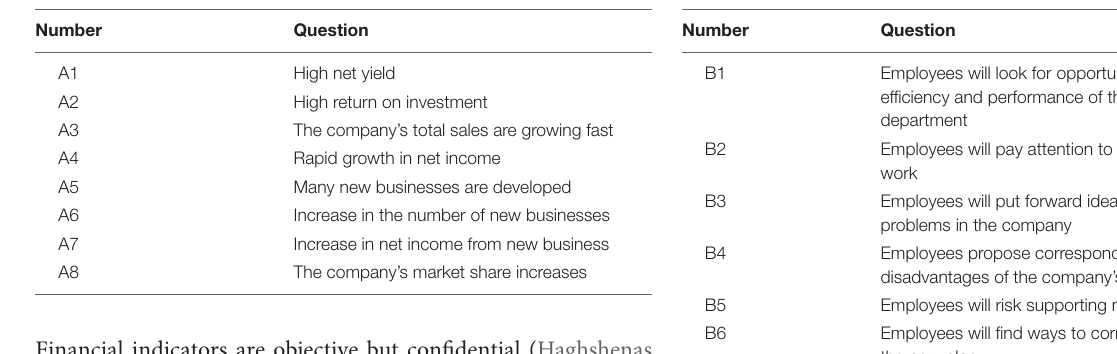
TABLE 1 | Corporate performance scale. TABLE 2 | Measurement indicators of innovation